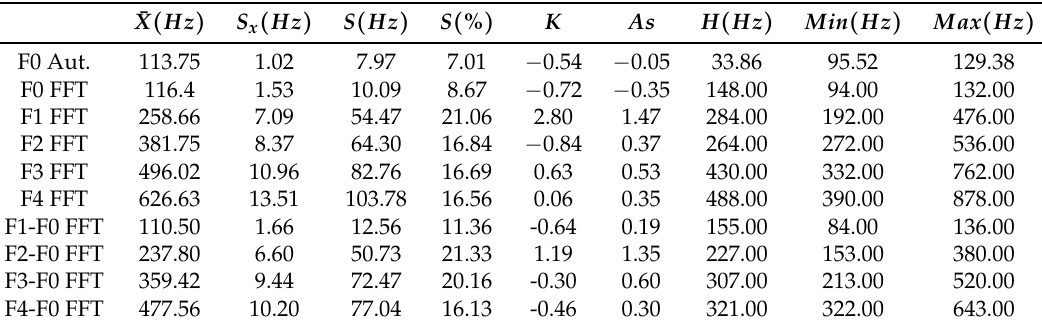
Table A3. Statistical descriptive measures of data without outliers by frequency measurement of the standard group of A. fraterculus .